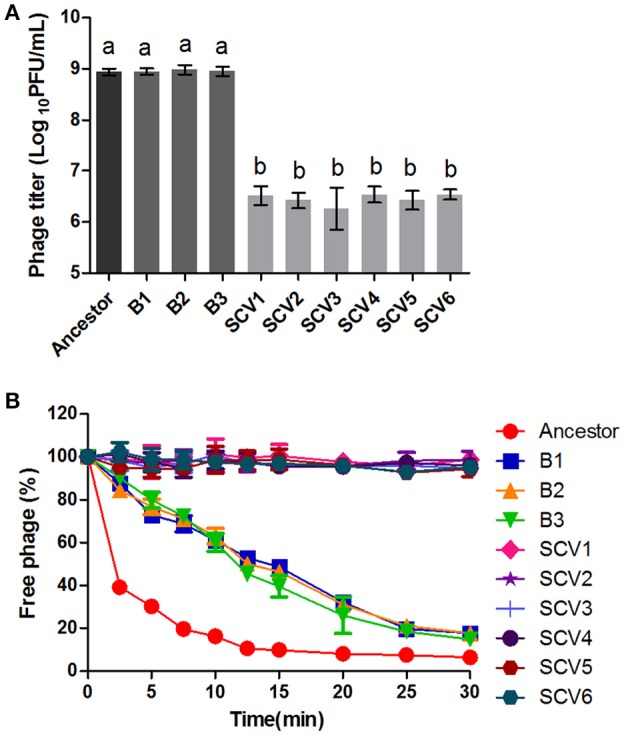
Susceptibility of the ancestor, B strains (non-Tetrahymena-exposed) and SCV strains (Tetrahymena-exposed) to phage. (A) Relative bacteriophage titer was defined as the plaque-forming units (PFU) of phage after coculture with the bacterial strains for 4 h. (B) The adsorption curves of phage. The titer of the free phage was determined after co-incubation of phage G65 with the bacterial strains at a regular interval of 2.5 min. The phages cultured alone served as control. The adsorption curve was drawn with time as abscissa and the percentage of un-adsorbed free phage as ordinate. Data are presented as the mean ± SD of three independent experiments, with each experiment being consisting of three replicates. Different lowercase letters (a, b) indicate significant differences (P < 0.05) among different bacterial strains.